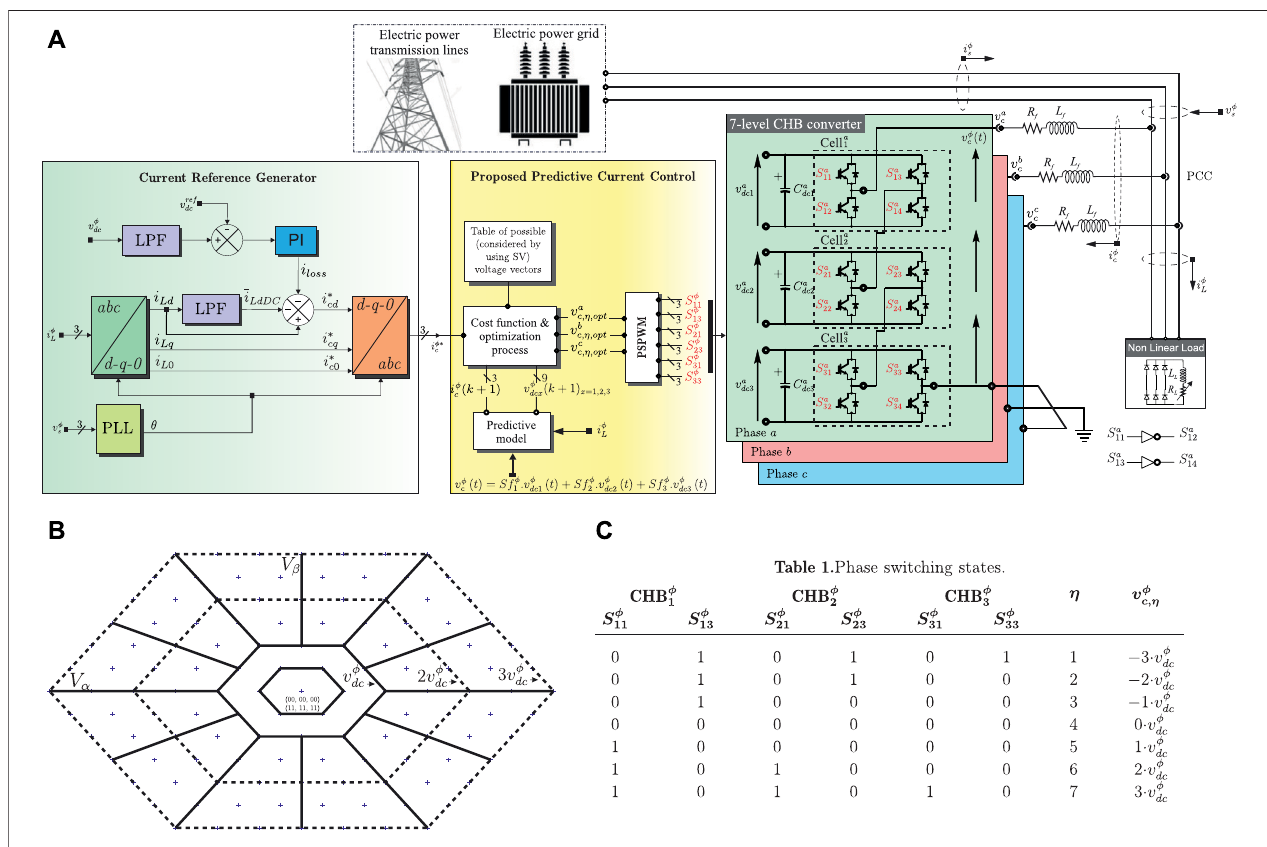
FIGURE 1 | (A) Control scheme for the 7-level APF based on H-Bridge converter. (B) 7-level space vector diagram in an α − β coordinate. (C) Phase switching states.